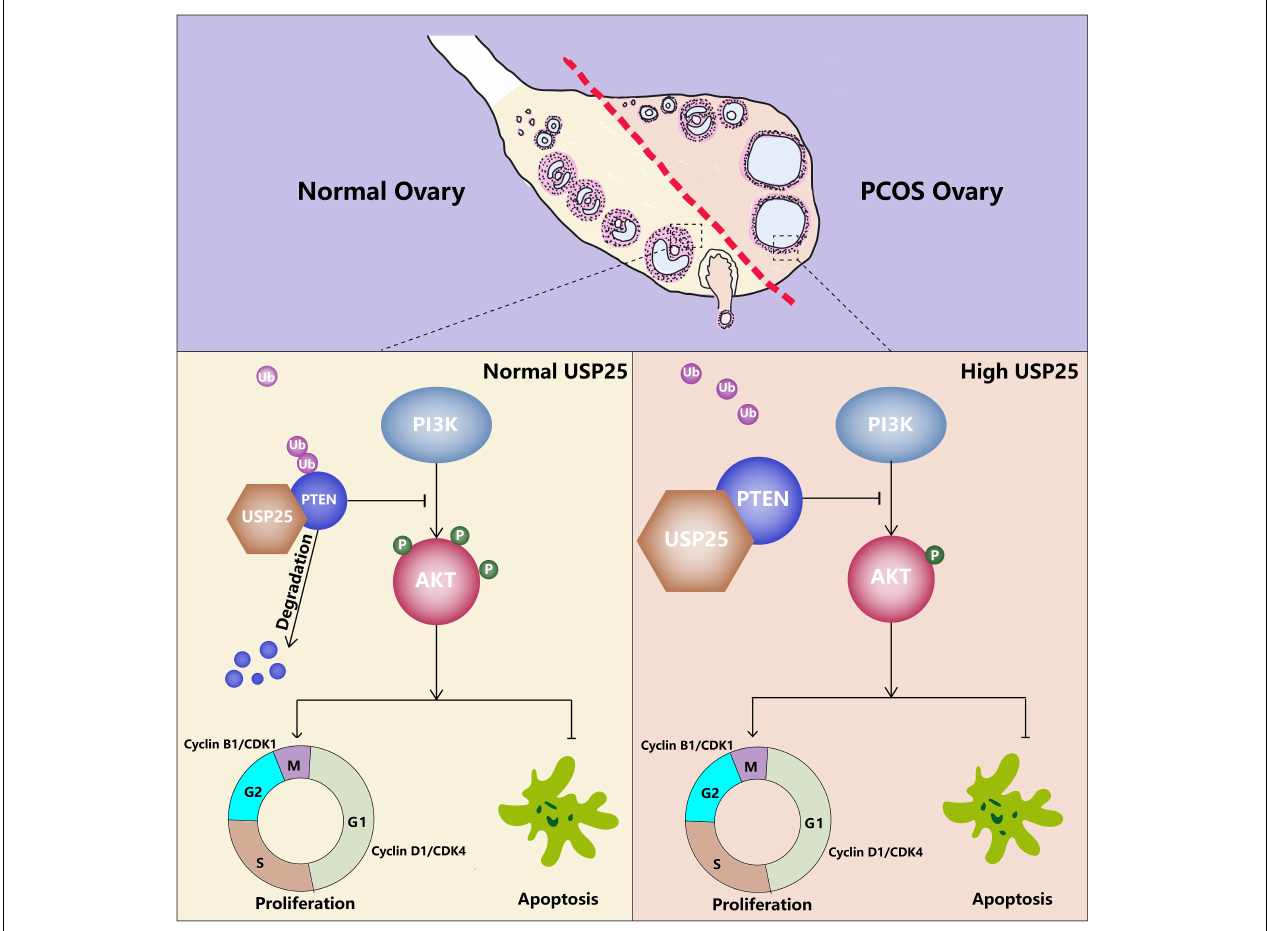
FIGURE 7 | Proposed model of the effect of USP25 during PCOS pathogenesis. Upregulated USP25 expression in the GCs of women with PCOS inhibits the ubiquitination of PTEN. Increased expression of PTEN negatively regulates the PI3K/AKT signaling pathway, thereby inhibiting granulosa cell proliferation and promoting granulosa cell apoptosis, leading to the development of